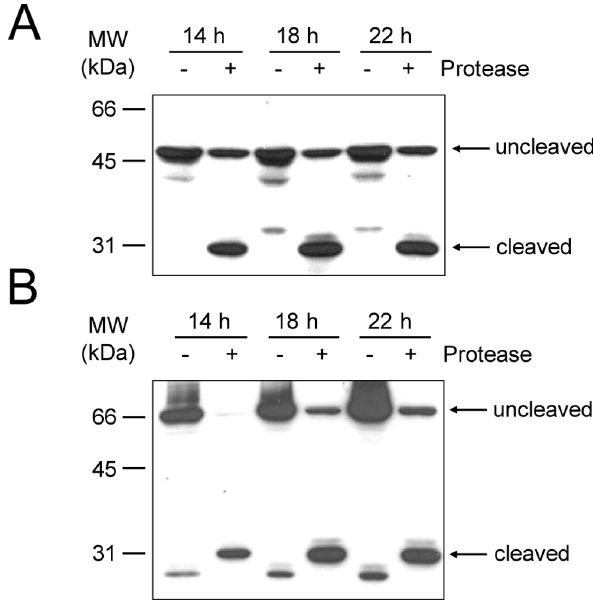
Figure 5. Western blot analysis of MBR protein cleavage. Type I ( A ) and type II ( B ) MBR proteins were expressed alone ( 2 ; lanes 1, 3, and 5 for A and B) or with protease ( + ; lanes 2, 4, and 6 for A and B). Cell lysates prepared after the indicated incubation times were subjected to immunoblotting with an anti-GFP antibody, as described in the Materials and Methods. A . The expected size of 50.2 kDa (uncleaved) and 27.4 kDa (cleaved) were observed with type I MBR protein. B . The expected size of 60.7 kDa (uncleaved) and 27.4 kDa (cleaved) were